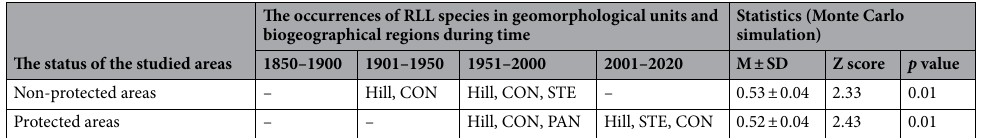
Table 1. The occurrence of RLL species within geomorphological units and biogeographical regions ordered over time periods (according to seriation analysis performed in PAST software). CON, continental bioregion; PAN, panonic bioregion; STE, stepic bioregion; –, a lack of data.